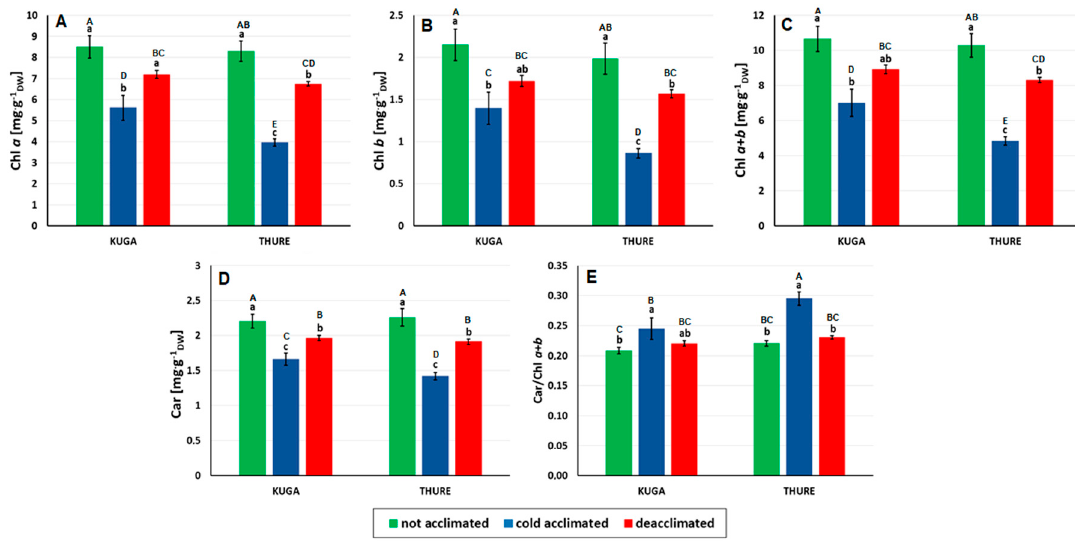
Figure 3. Photosynthetic pigments in the leaves of the not acclimated, cold-acclimated, and deacclimated oilseed rape cv. Kuga and cv. Thure: ( A ) content of chlorophyll a , ( B ) content of chlorophyll b , ( C ) content of chlorophyll a + b , ( D ) content of carotenoids, ( E ) carotenoids / chlorophyll a + b ratio. Mean values ± SD marked with the same letters did not di ff er significantly at p ≤ 0.05 according to Duncan’s test, n = 5; lowercase—comparison separately within each cultivar, uppercase—comparison between cultivars.